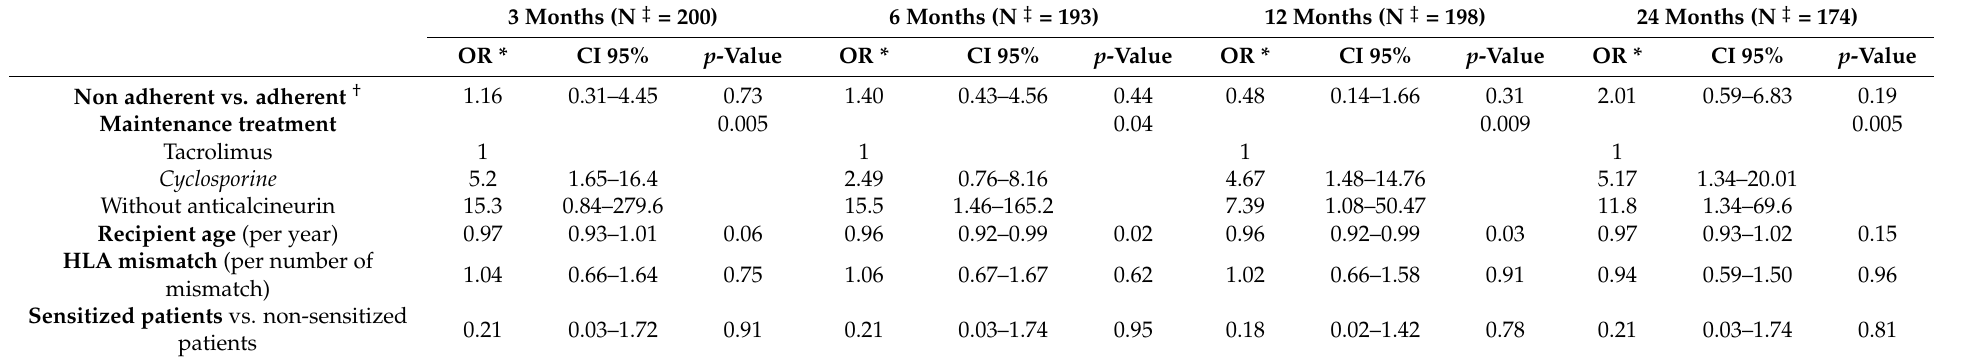
Table 3. Effect of non-adherence measured by the Morisky scale and immunosuppression regimen on the risk of dn DSA apparition between 2 and 3 years post-transplant among patients with an available serum sample. Results of logistic regression model. Multivariable